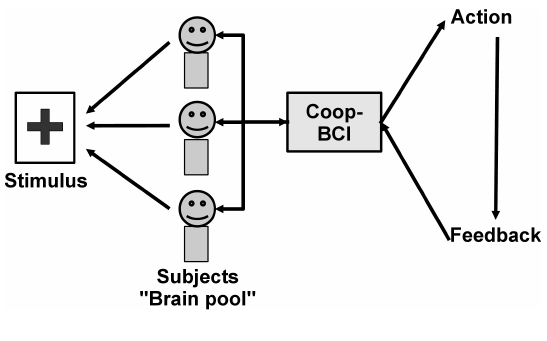
Figure 2. Cooperative BCI based on the detection of